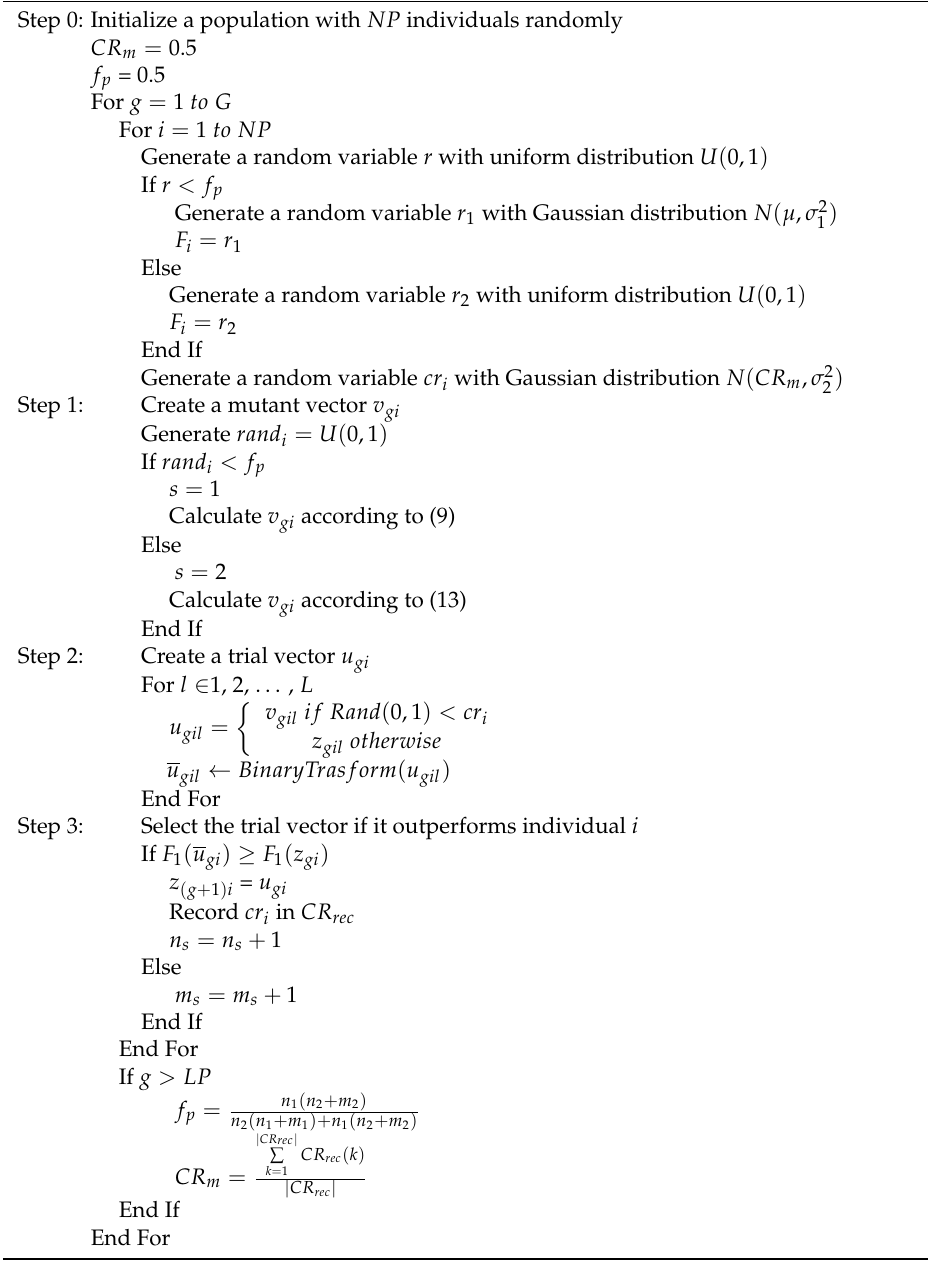
Table 3. The pseudo code of SaNSDE Algorithm. Discrete Self-Adaptive Neighborhood Search Differential Evolution with (SaNSDE)